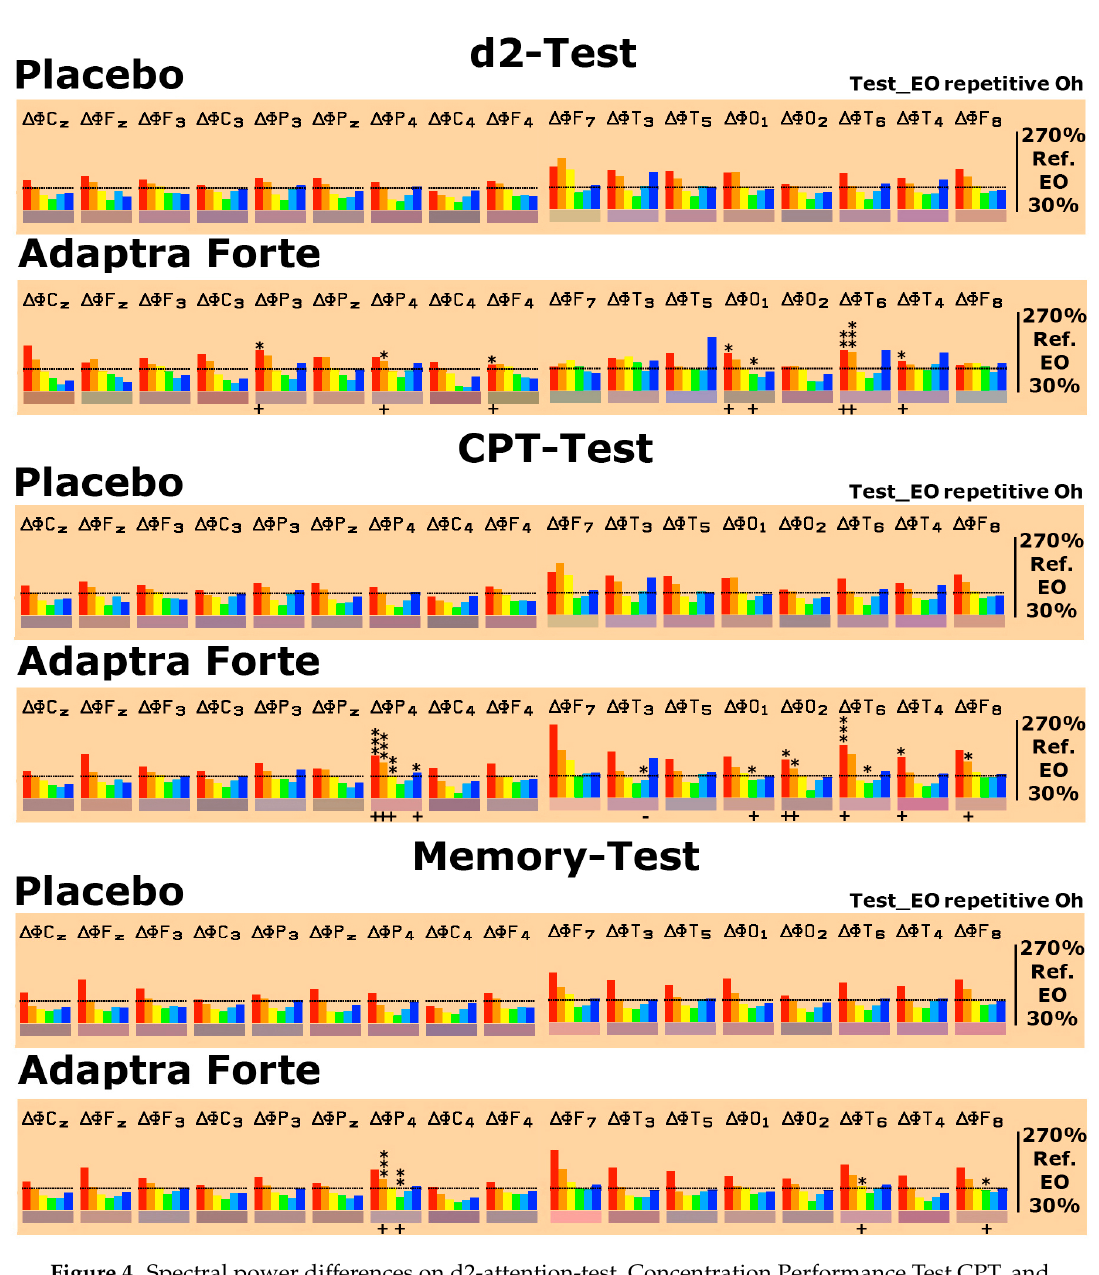
Figure 4. Spectral power differences on d2-attention-test, Concentration Performance Test CPT, and memory tests as deviation from the eyes open recording condition, which was set as 100% on the last experimental day with the administration of placebo or Adaptra ® Forte in all brain regions represented by the electrode positions. C = central, p = parietal, O = occipital, F = frontal, and T = temporal. Even numbers are located in the right hemisphere, uneven numbers in the left. Frequencies: red = δ , orange = θ , yellow = α 1, green = α 2, turquoise = β 1, and blue = β 2. The spectral power (between 30% and 270% on the ordinate of the bar graph) was averaged over 5 min and plotted against the eyes open condition (set as 100%), thus reflecting the e ff ect of the placebo or Adaptra ® Forte. Statistical significance (non-parametric sign test) between placebo and Adaptra ® Forte: * p < 0.12; ** p < 0.05; *** p < 0.01.